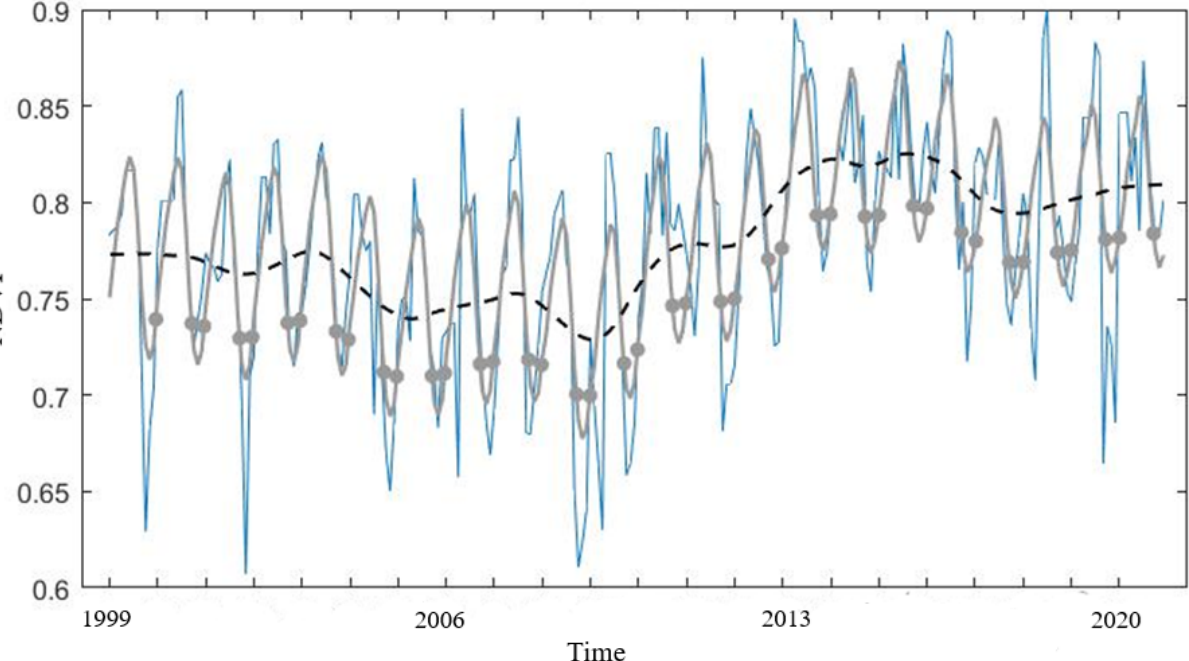
Figure 7. Mangrove forest seasonal trend decomposition in TIMESAT with Landsat NDVI data and dense time-series 1999–2020, black line indicates the seasonal trend, grey dots display the start and end of the growing season for mangrove forest in the mid-section our study region, Figure 1, Bowen to Shoalwater and Corio Bays Area Ramsar Wetland, Central Queensland.